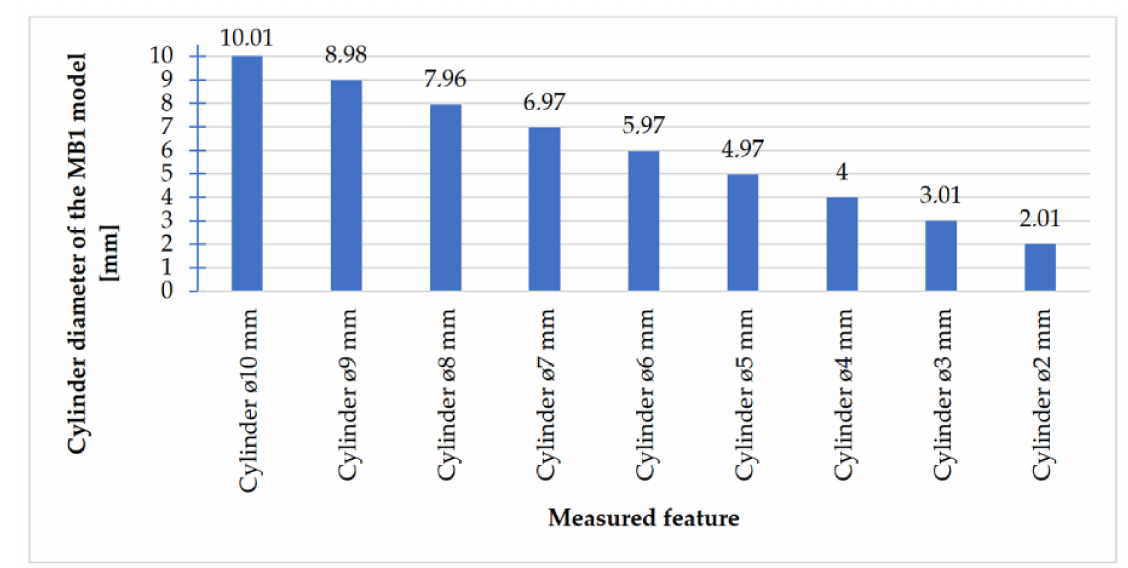
Figure 20. Average values calculated based on the cylinders measurement results with dimensions Ø10–Ø2 mm.